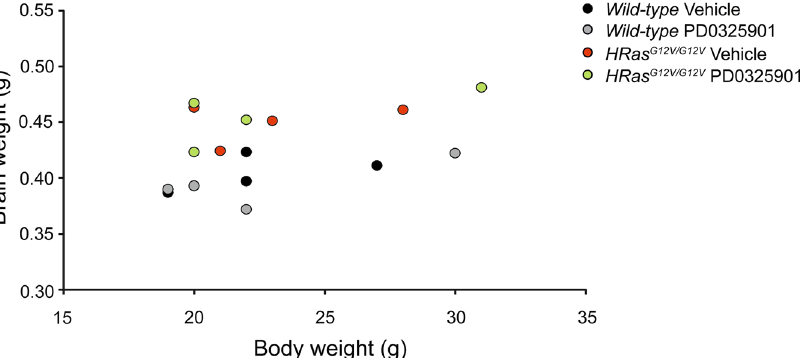
Figure 9. Treatment with MEK inhibitor does not reduce the increased brain weight of HRas G12V/G12V mice. ( A ) Daily treatment with 2 mg/kg of PD0325901 for 4 weeks does not reduce the increased brain weight observed in HRas G12V/G12V mice (effect of genotype: brain weight: F 1,12 = 28.20, P < 0.01; body weight: F 1,12 = 0.05, P = 0.83; effect of treatment : brain weight : F 1,12 = 0.45, P = 0.84, body weight: F 1,12 = 0.01, P = 0.91; interaction genotype * treatment: brain weight: F 1,12 = 0.65, P = 0.43; body weight: F 1,12 = 0.00, P = 1.00). Data are presented as individual values of brain vs. body weight from n = 4 mice per each group. Statistical test: two-way